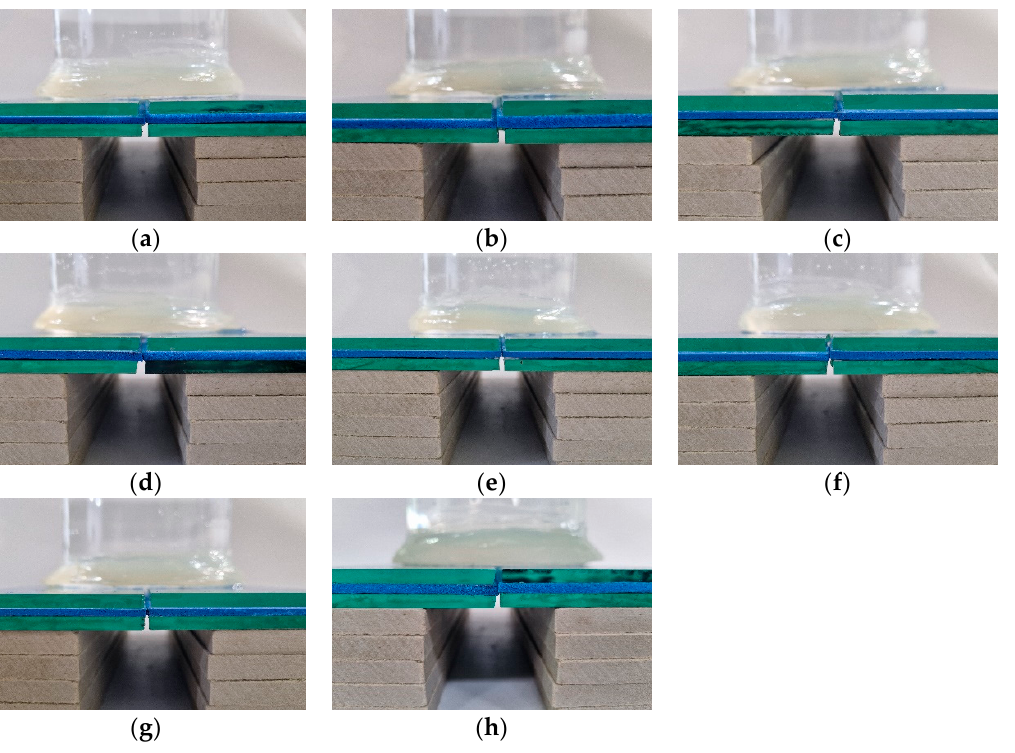
Figure 15. The waterproofing performance evaluation results; ( a ) Non-treatment (waterproofed); ( b ) Hydrochloric acid (waterproofed); ( c ) Nitric acid (waterproofed); ( d ) Sulfuric acid (waterproofed); ( e ) Alkali (waterproofed); ( f ) Sodium chloride (waterproofed); ( g ) Freeze-thaw (waterproofed); ( h ) Repeated wet-dry treatment (waterproofed) .